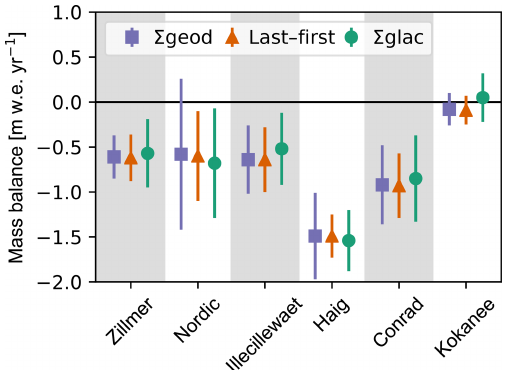
Figure 8. Summed annual mass balance from glaciological data ( P glac), geodetic data ( P geod), and last–first (cid:49) DEM. Last–first (cid:49) DEMs were created by differencing the first available DEM (2014 or 2015 late summer) from the last available DEM (2017) for each site (Table 2). Errors denote 2 σ